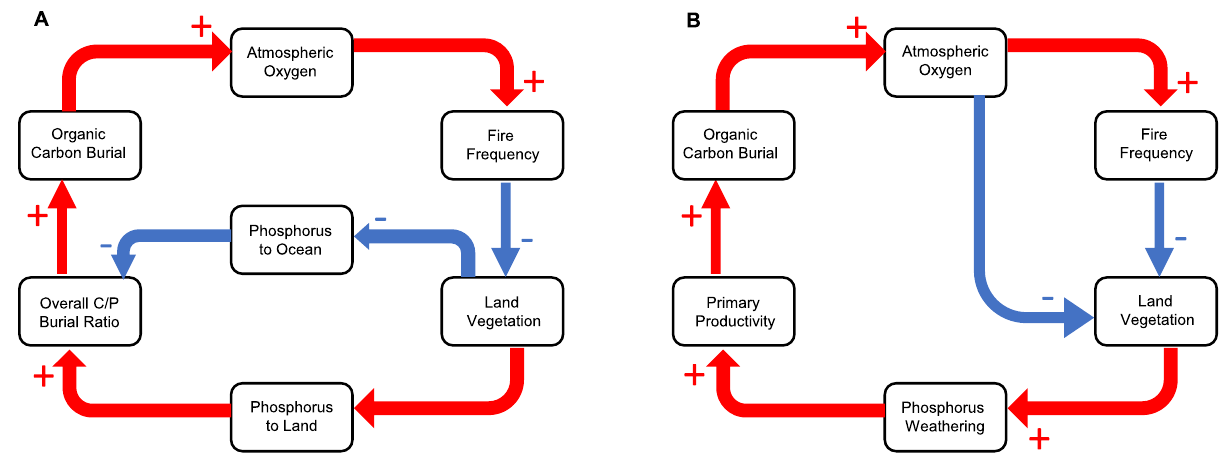
Fig. 1 Negative fi re feedbacks on atmospheric oxygen. Feedback possibilities are via: A Phosphorus redistribution and B phosphorus weathering with the inclusion of the direct feedback of oxygen on plant productivity. The sign of each arrow represents the relationship between the two connecting boxes, with a (red) plus sign indicating a direct relationship (e.g. increasing oxygen increases fi re frequency whilst decreasing oxygen decreases fi re frequency) and a (blue) negative sign indicates an inverse relationship (e.g. increasing fi re frequency decreases land vegetation whilst decreasing fi re frequency increases land